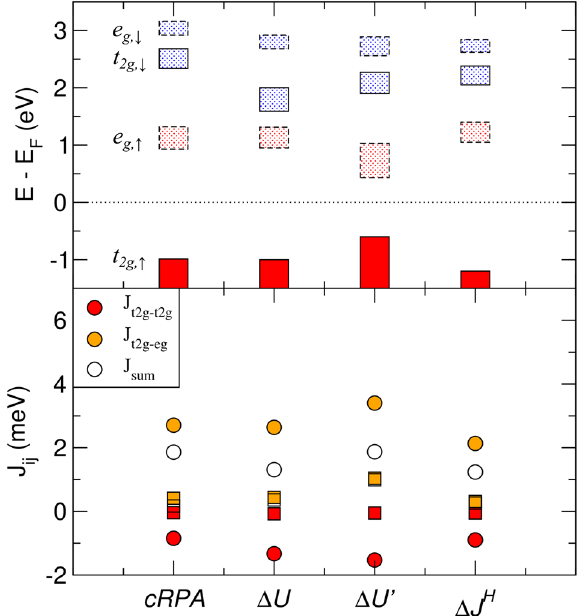
Fig. 4 Coulomb interaction effects to the electronic and magnetic properties of the ( d + p )-model. a Electronic properties: red and blue stands for spin up and down polarized bands. Continuous and dashed lines correspond to t 2 g and e g bands, respectively. The dotted line indicates the Fermi energy position. The size of the boxes is related to the bandwidth. b Magnetic exchange interac- tions: circles and squares denote 1st and 2nd neighbor intra-layer exchange couplings obtained with the MFT. Red, orange, and empty circles stand for J t 2 g – t 2 g , J t 2 g – eg , and J sum which is the sum of both interactions. For both, 1st and 2nd neighbors, t 2 g – t 2 g interactions are always AFM, while the t 2 g – eg ones are